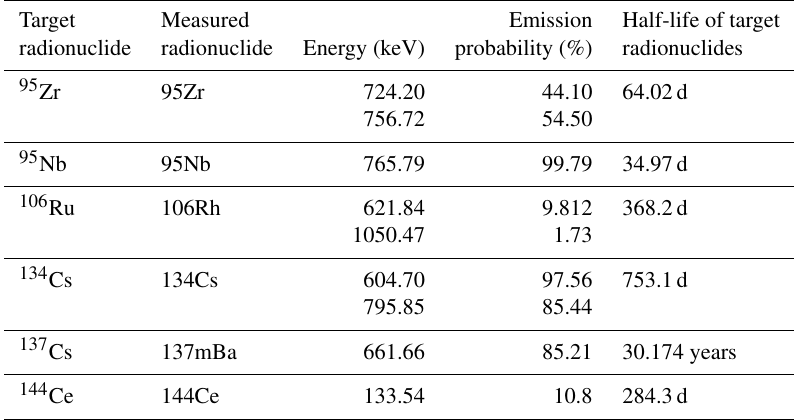
Table A2. Decay radiation information from the master library, integrated into a spectrum-analysing software tool, Gelicam (EG&G ORTEC, USA), used in gamma analyses. Activities of 106 Ru and 137 Cs in samples were estimated via their gamma-radiation-emitting progenies, namely 106 Rh and 137 m Ba,